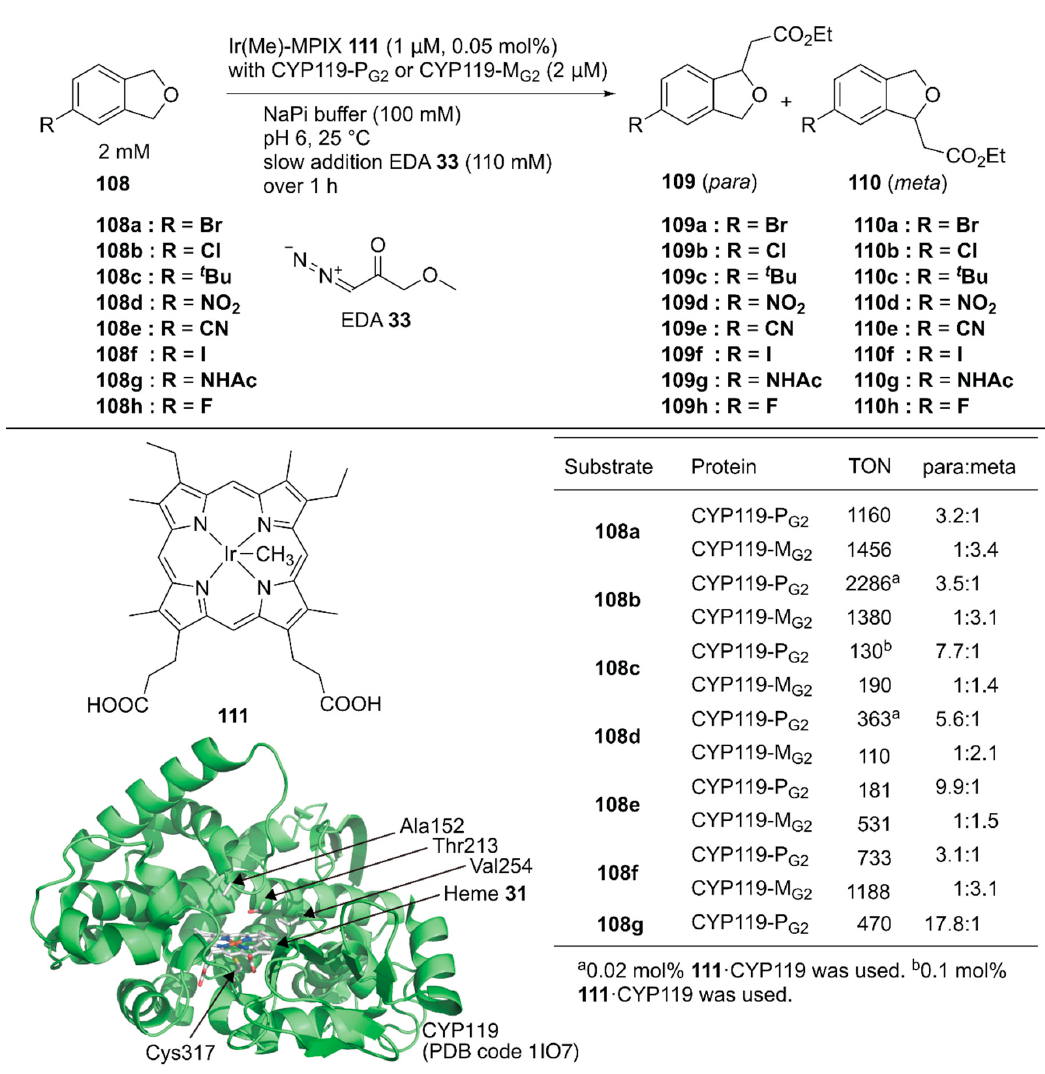
Figure 21. Carbene insertion reaction to phthalane derivatives catalyzed by CYP119 variants reconstituted with the Ir(Me)-MPIX complex 111 . Adapted from [122].